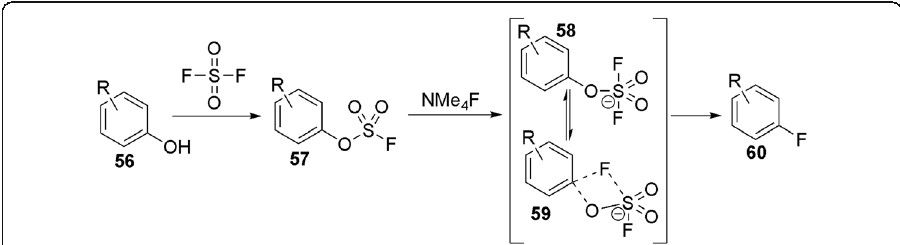
Fig. 16 Deoxyfluorination using arylfluoro sulfonate intermediates and the proposed